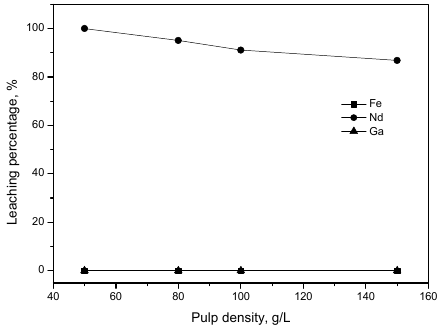
Figure 7. Effect of pulp density on the leaching of the oxide mixtures by 1.0 M HCl in EG. Operation conditions: T = 25 °C, time = 120 min, stirring speed = 400 rpm.